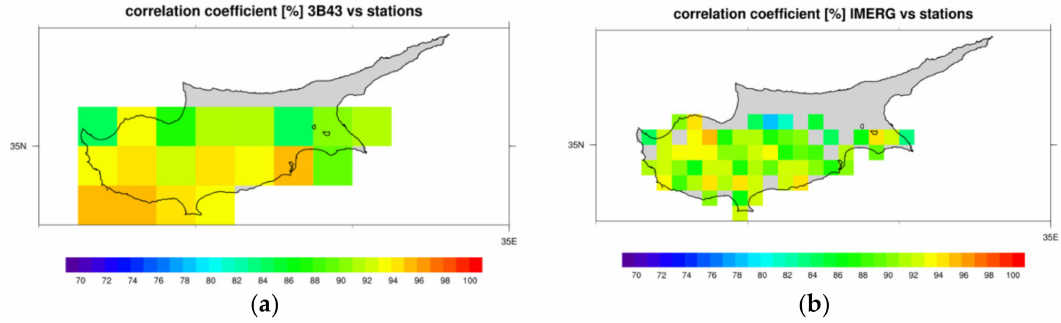
Figure 5. Correlation coe ffi cient at grid cell level between the gauge stations and the TRMM ( a ) and IMERG ( b ) data.